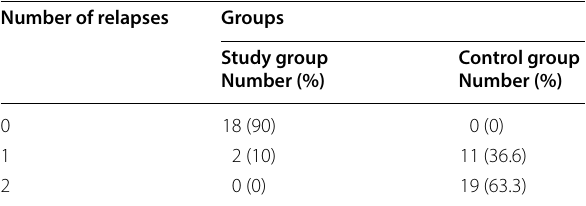
Table 5 Number of relapses in each study group during the 12-month study period Number of